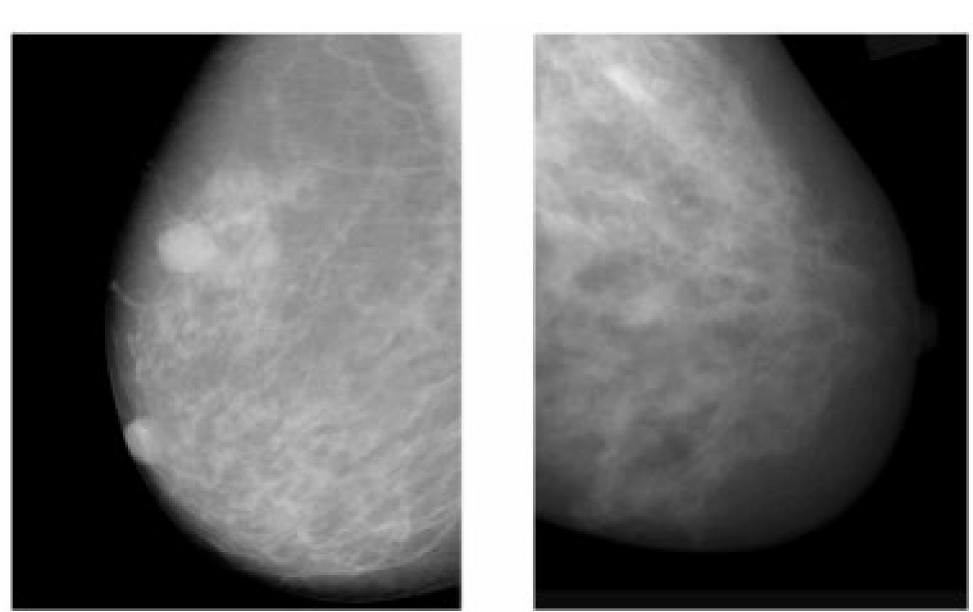
Figure 1. Example of breast cancer images using traditional film MMs. Reprinted/adapted with permission from [49]. 2021,